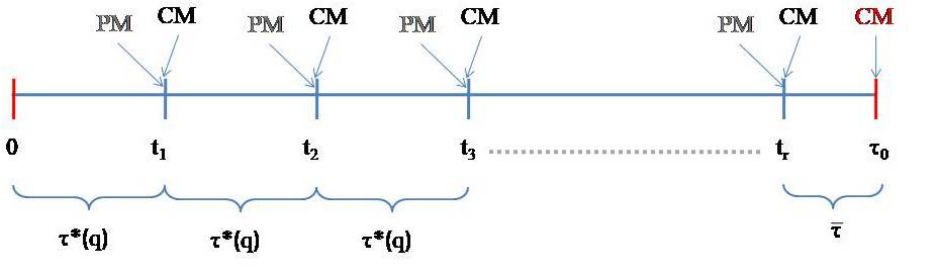
Figure 2. Maintenance